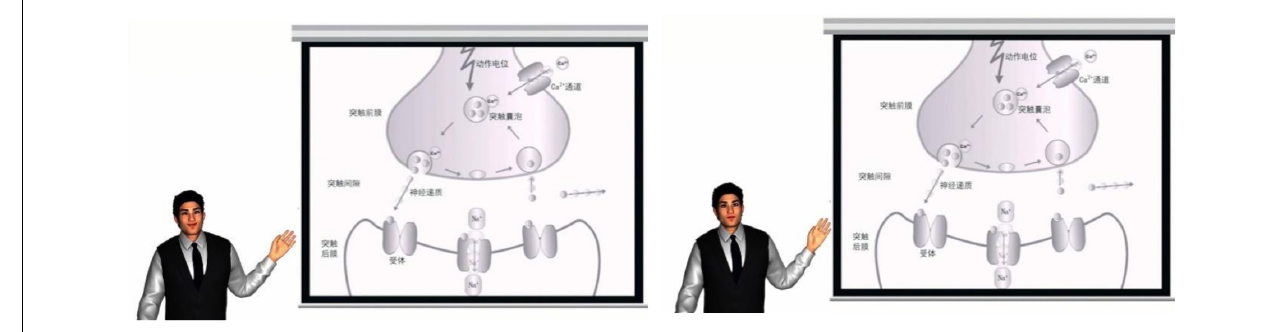
FIGURE 1 | Example frames from multimedia learning materials: Affective pedagogical agent (Left) and neutral pedagogical agent